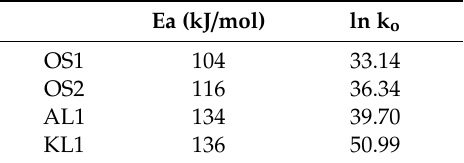
Table 2. Apparent kinetic parameters for 2-propanol decomposition for all the ACM catalysts. Ea (kJ /